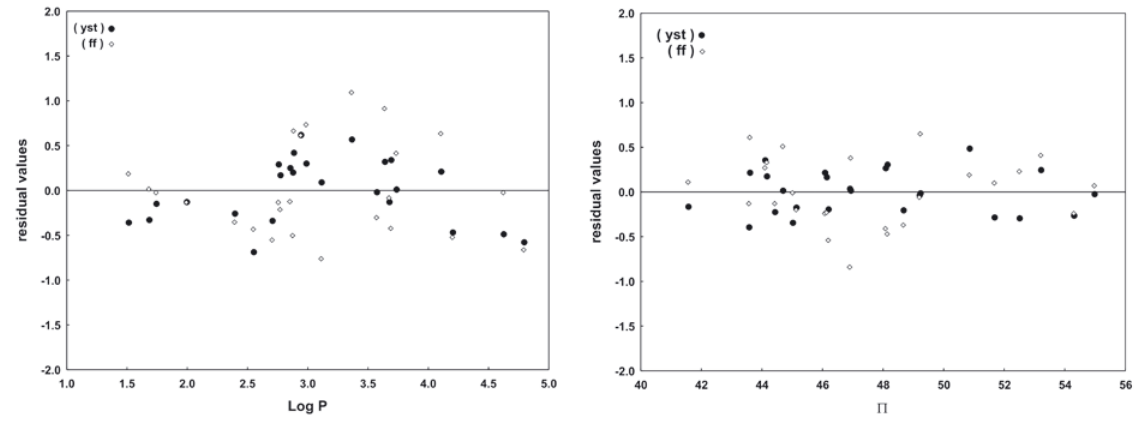
Figure 1. Graphical representation of residual values versus the log P and P data from Eqs. 3 yst and 3 ff